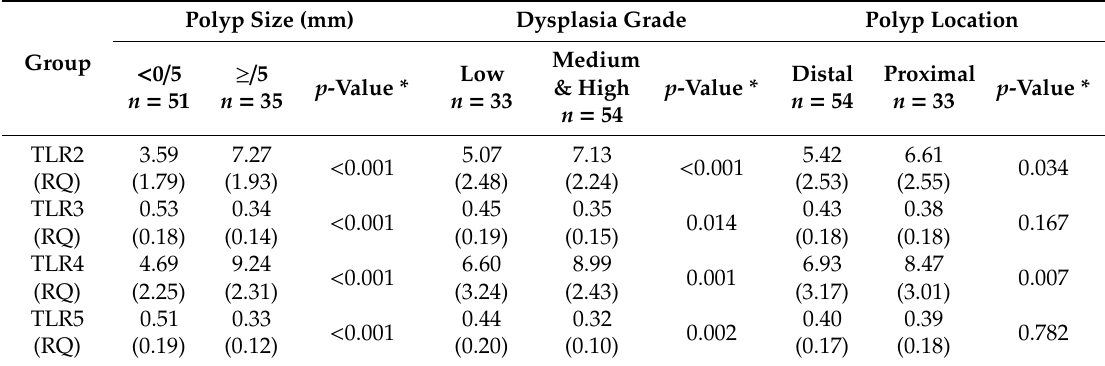
Table 3. Association between the relative expression of TLR2, 3, 4, and 5 and polyp size, location, and grade of dysplasia.